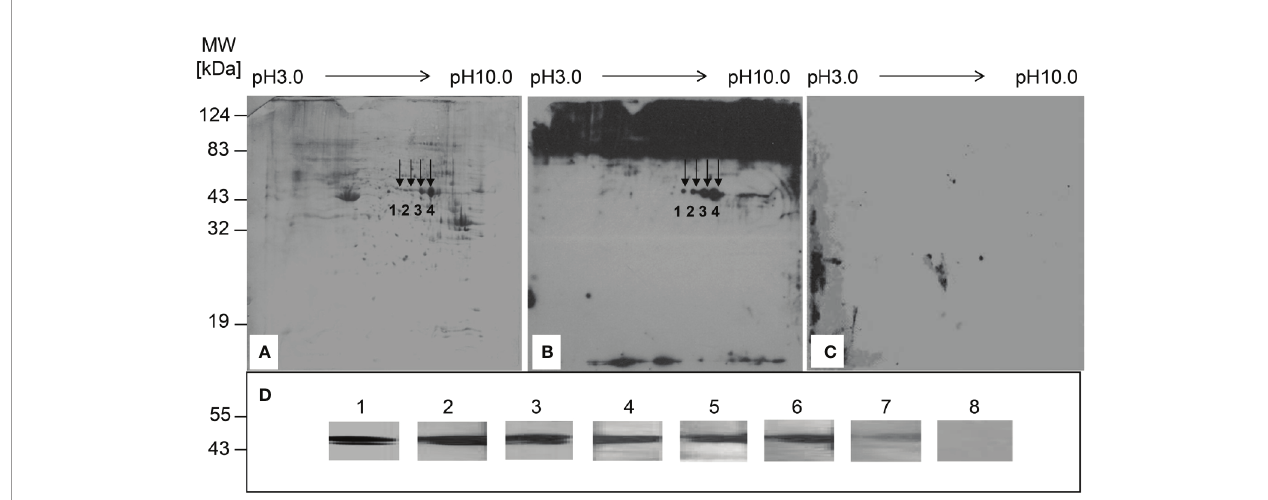
FIGURE 1 | Identi fi cation of the liver proteins recognized by serum autoantibodies from patients with chronic hepatitis B (CHB). (A) Proteins from HepG-2 cells were separated by two-dimensional electrophoresis and visualized by Coomassie blue staining. (B) Proteins from HepG-2 cells were transferred to a PVDF membrane, followed by incubation with a mixture of diluted sera samples (1:100) from 20 patients with CHB. (C) PVDF membrane was incubated with a mixture of diluted serum samples (1:100) from 15 healthy controls (HCs). Arrows indicate the proteins recognized by serum samples from patients with CHB. (D) Western blot analysis was performed to detect recombinant human EBP-1 using polyclonal anti-EBP-1 antibody (1:500) (lane 1) or diluted sera (1:100) from CHB patients (lane 2 – 7) or HC (lane